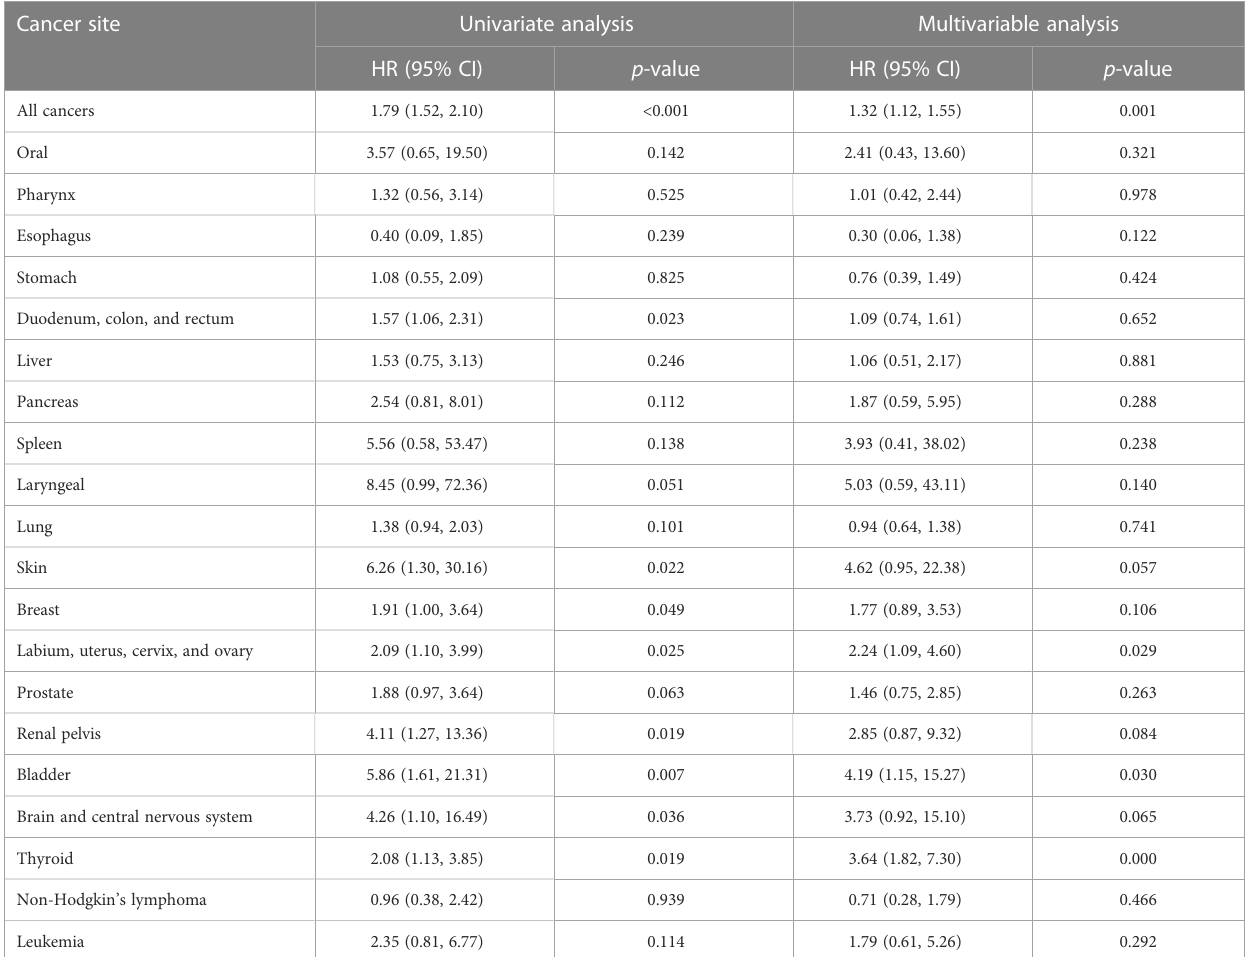
TABLE 3 Association between MAFLD and the development of cancers. Cancer